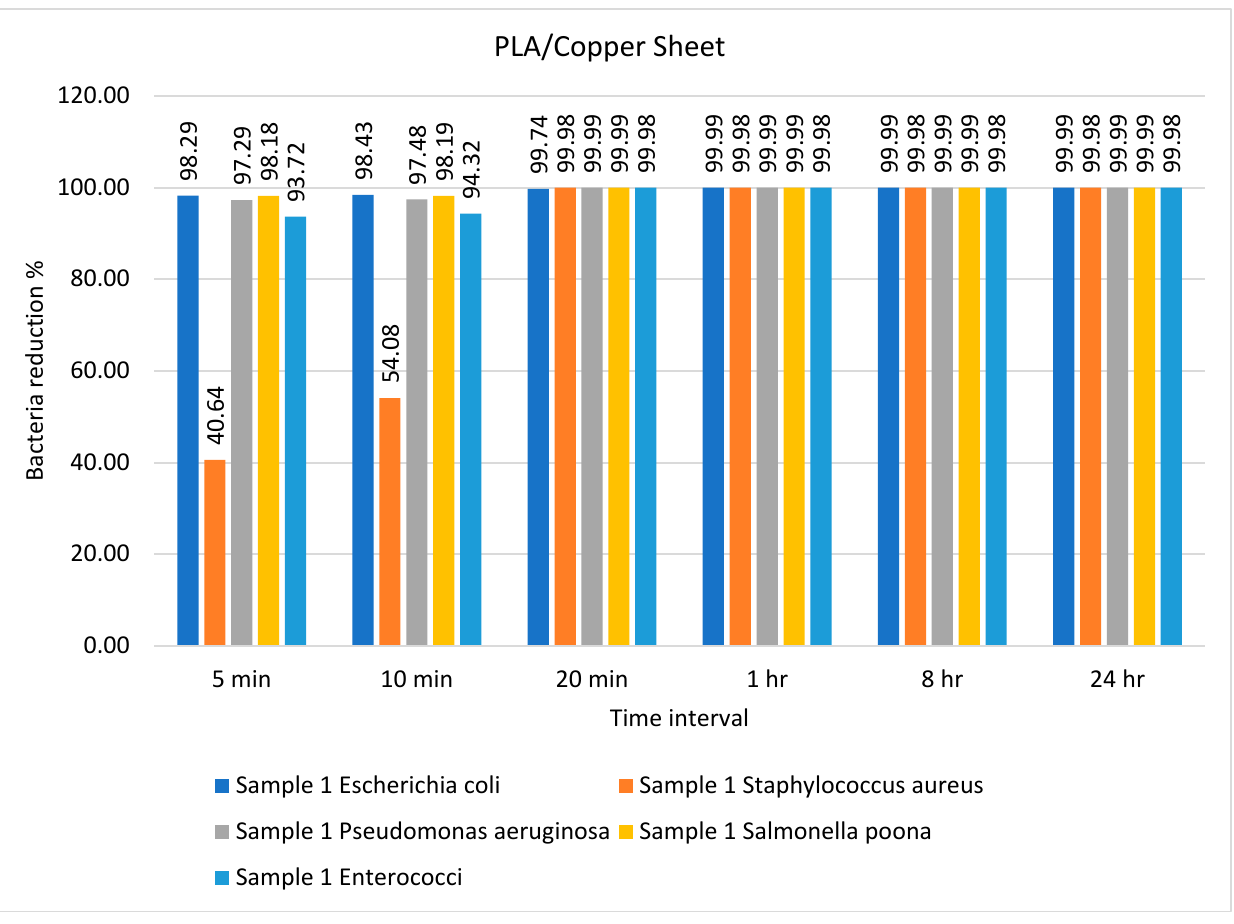
Figure 6. Percentage bacterial reduction for PLA/copper sheet over different time intervals.